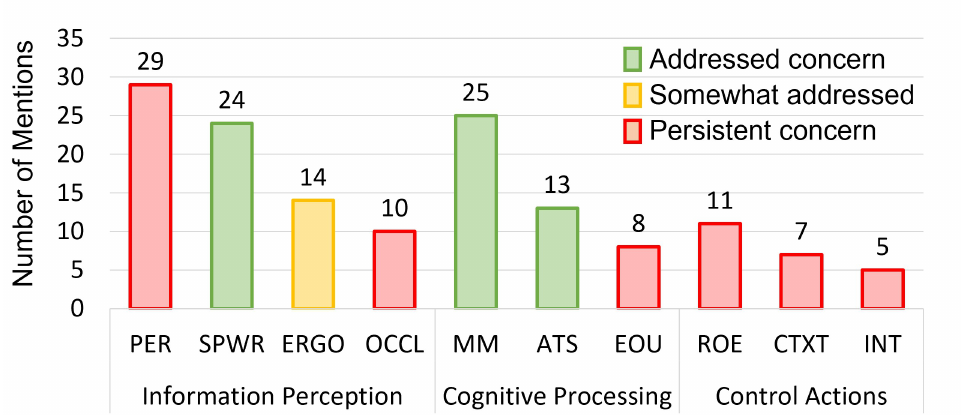
Figure 11. Distribution of the 57 articles included in the review based on the reported human factors related considerations. Human factors considerations included risk of error (ROE), spatial awareness (SPWR), ease of use (EOU), perception (PER), ergonomics (ERGO), attention shift (ATS), interaction challenges (INT), mental mapping (MM), context (CTXT), hand-eye coordination (HE), and occlusion